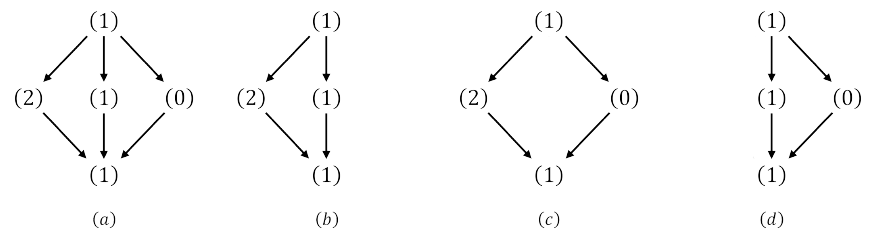
Figure 7: All the four net representations are legal although the middle level of the representations are